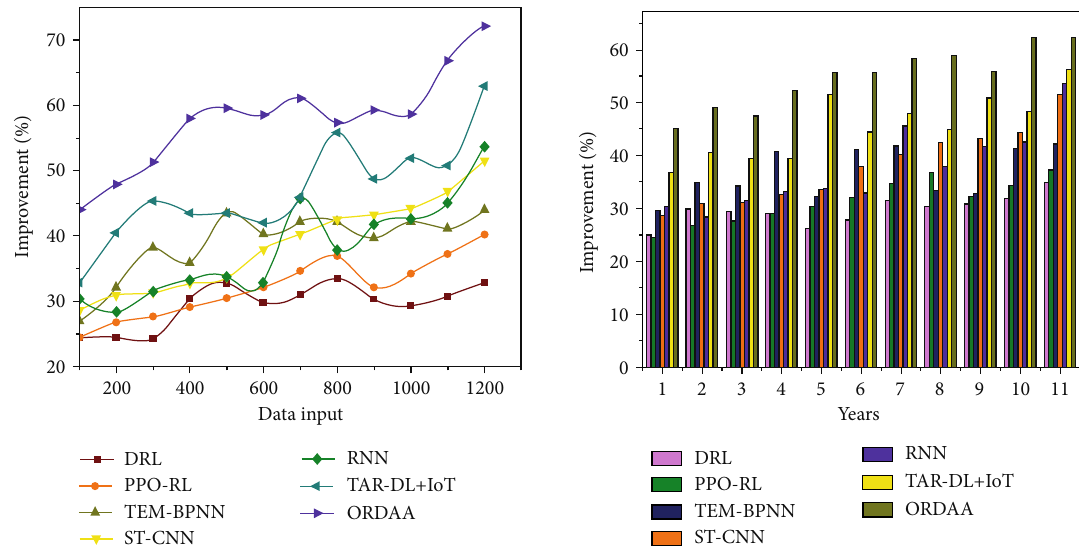
Figure 9: Improvement